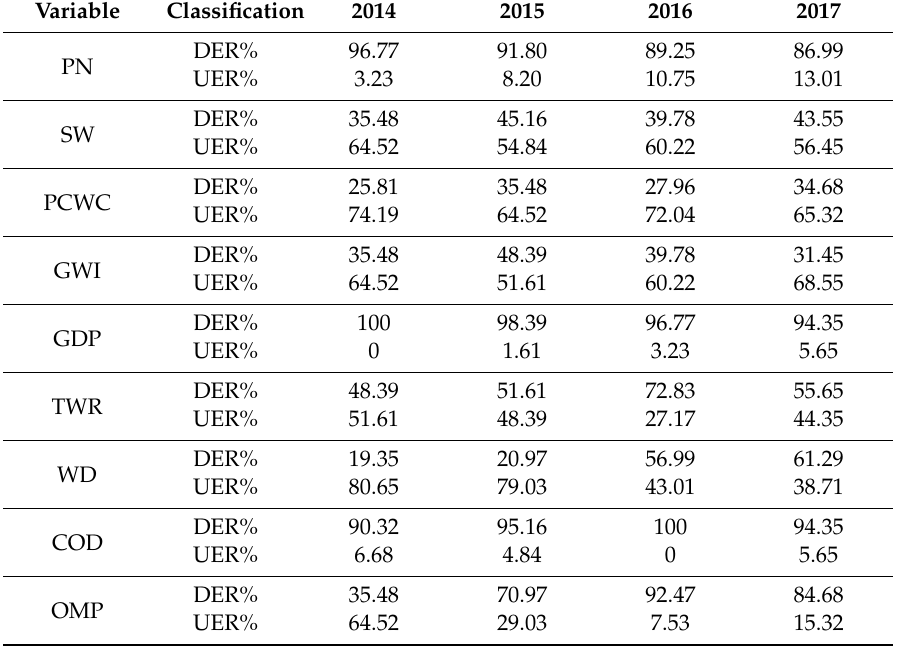
Table 7. Downside error rate percentage (DER%) and upside error rate (UER%) of all variables with resampling DEA in 2014–2017.